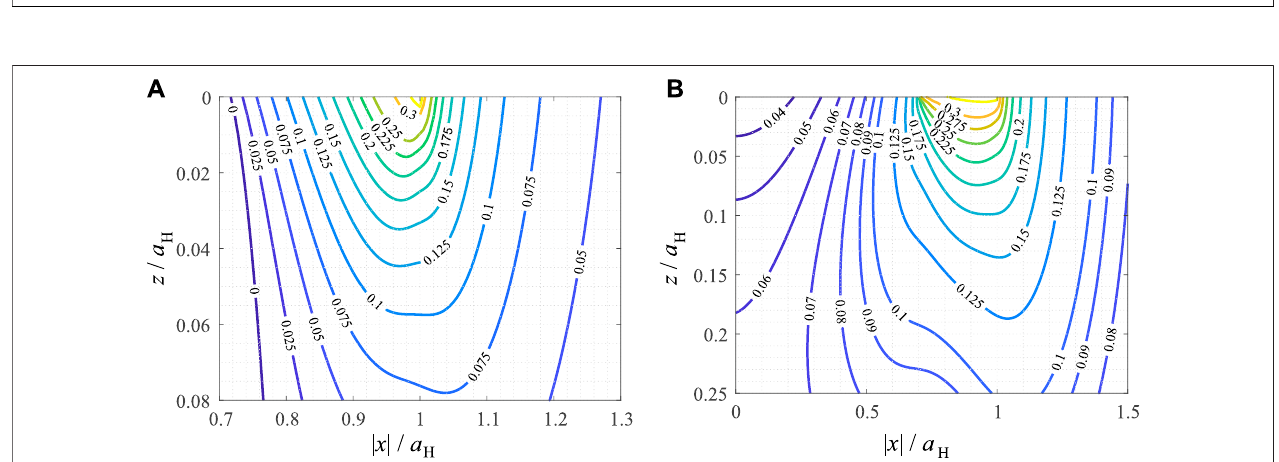
FIGURE2| Contourlinediagramsofcriticalplanefatiguecrackinitiationcriteria,normalized fortheircharacteristicscales,intheloadingplaneforapartialslipplane parabolic contact under oscillating tangential load. (A) Smith-Watson-Topper parameter (B) Findley parameter.